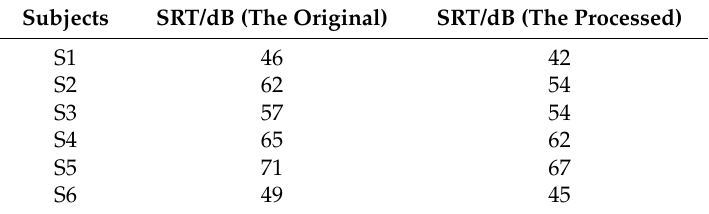
Table 5. Speech reception threshold (SRT) using the original and the processed